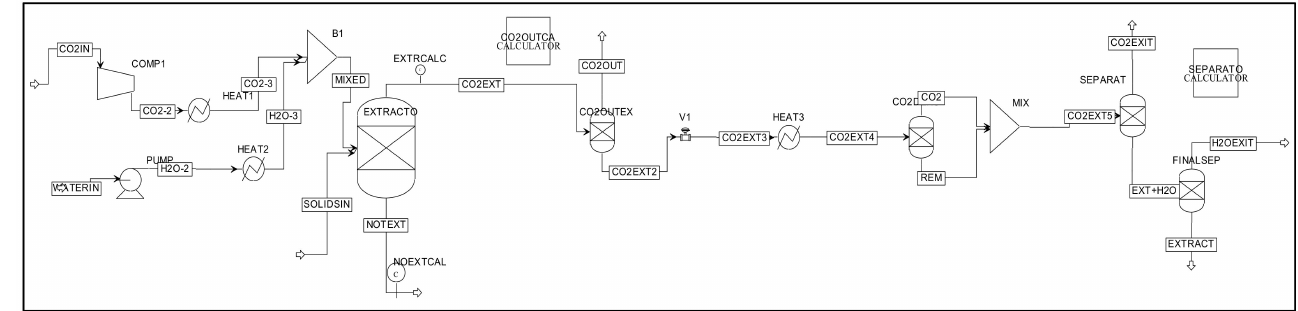
Figure 3. Aspen Plus Supercritical Extraction process flow